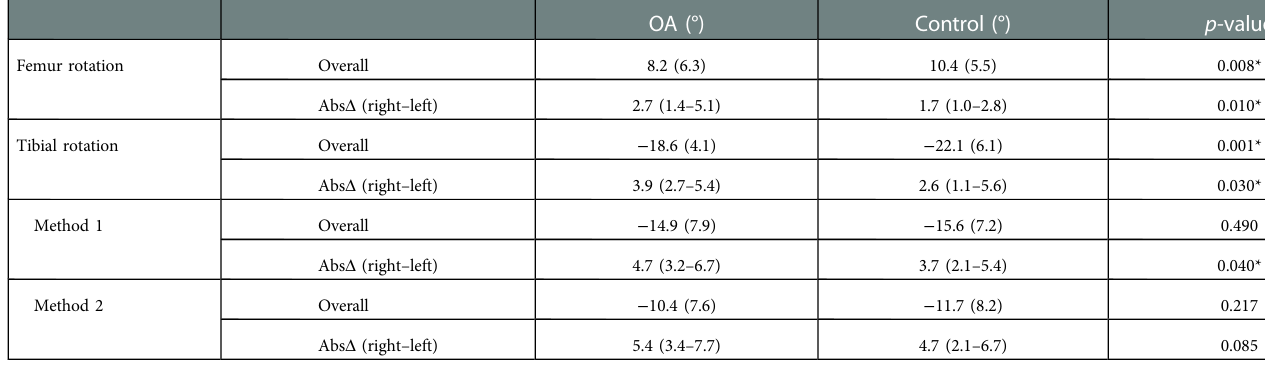
TABLE 2 Differences of measurement between OA and control